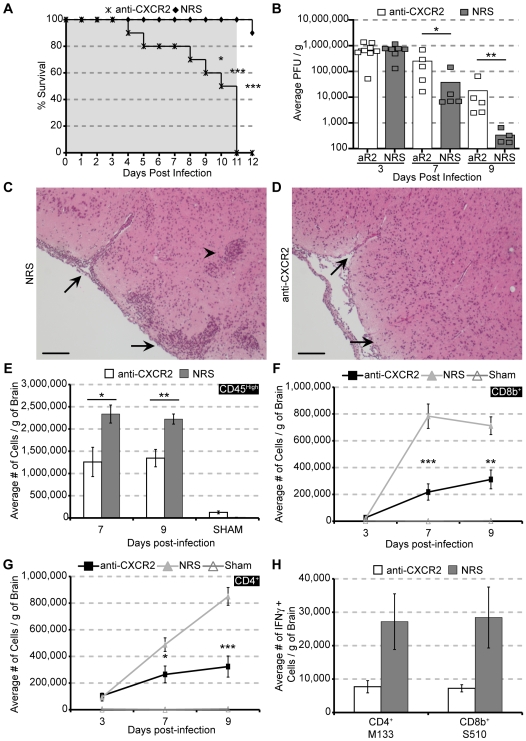
Neutralizing CXCR2 during acute JMHV infection increases mortality, viral burden, and reduces T lymphocyte infiltration.CXCR2 neutralizing antiserum or normal rabbit serum (NRS) was administered every other day from days -1 to 11 p.i. to C57BL/6 mice i.c. infected with 500 PFU of JMHV. The shaded area indicates the treatment window. Treatment with anti-CXCR2 significantly increased mortality (A) compared to NRS-treated mice (anti-CXCR2, n = 10; NRS, n = 10), and this was associated with increased viral titers within the brains (B) of anti-CXCR2-treated mice compared to control mice. Data presented within panels A and B are cumulative results from 2 experiments. Representative H&E staining of brains from (C) NRS or (D) anti-CXCR2 mice at day 9 p.i. reveals a drastic reduction in meningeal (arrows) and parenchymal (arrowhead) inflammation following CXCR2 neutralization. Flow cytometric analysis revealed significantly reduced cellular infiltration of CD45high cells (E) and both CD8b+ (F) and CD4+ (G) T lymphocyte subsets. In addition, intracellular IFN-γ staining following ex vivo stimulation with immunodominant CD4+ (M133–147) or CD8+ (S510–518) epitopes revealed reduced numbers of virus-specific T cells within the brains of anti-CXCR2-treated mice compared to NRS-treated mice at day 7 p.i. (H). Data in panels E-H are representative of 2–4 independent experiments with a minimum of 4 mice per time point in each experimental group. *p<0.05, **p<0.01, ***p<0.001 compared to NRS-treated mice. Bars: (C & D) 100 µm.